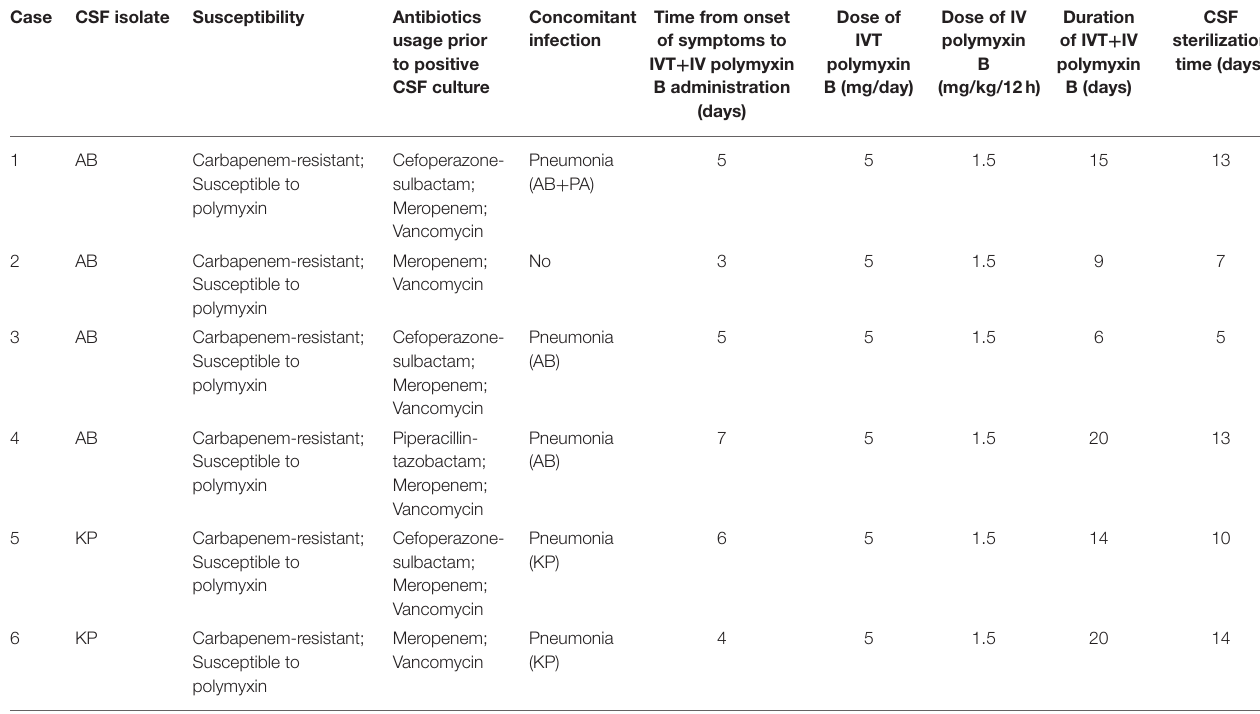
TABLE 3 | Cerebrospinal fluid (CSF) culture and treatment strategies for each patient. Case CSF isolate Susceptibility